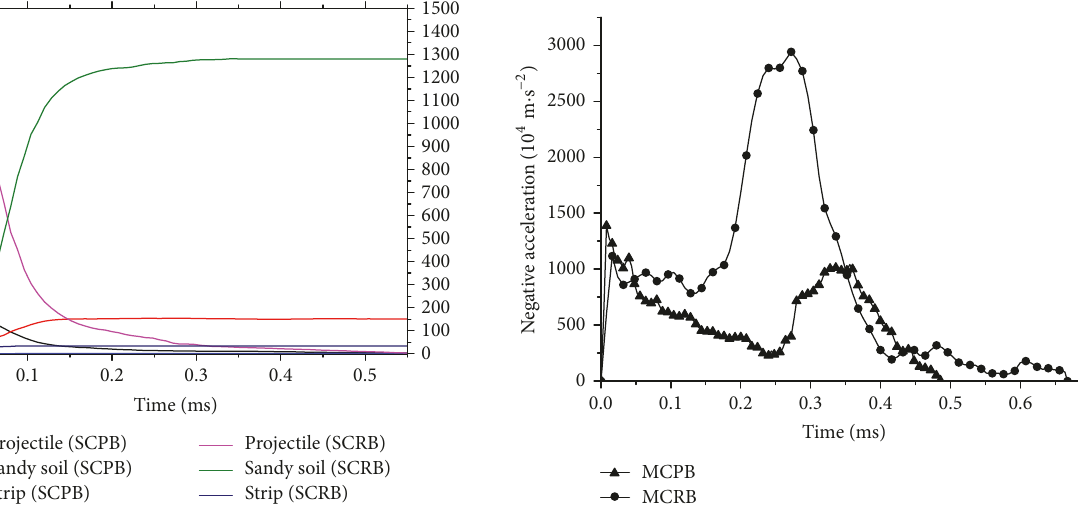
Figure 24: Negative acceleration of MCPB and